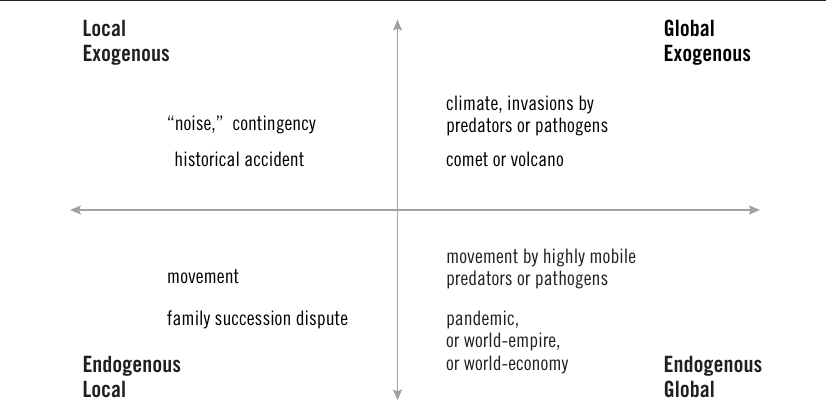
Figure 1– Dimensional Continua of Mechanisms of Spatial